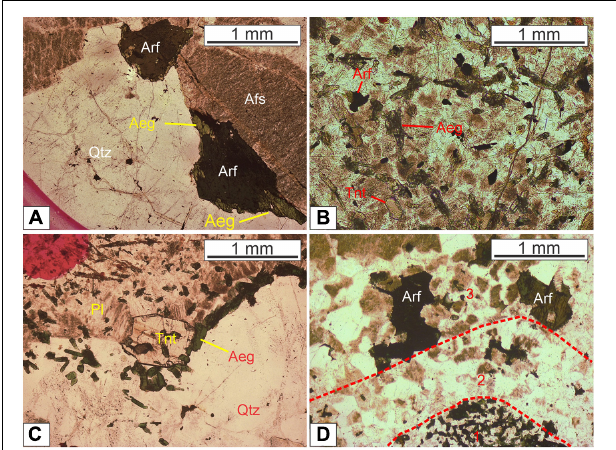
FIGURE 3 | Thin section photomicrographs showing (A) mantling texture in the granite; (B) titanite in MMEs; (C) mantling texture in the MMEs; (D) transitional boundary (1-Fine to microgranular enclaves; 2-Transition zone between granite and enclaves; 3-Medium grained arfvedsonite alkali feldspar granite). Mineral abbreviations: Qtz-quartz, Pl-plagioclase, Afs-alkali feldspar, Arf-arfvedsonite, Ae-aegirine, and Tnt-